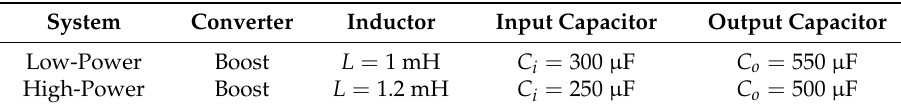
Table 2. Design parameters of the boost converter.